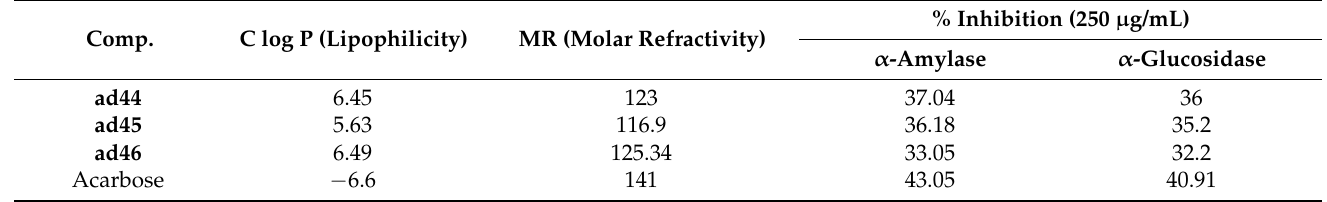
Table 49. Antidiabetic potential of the compounds ( ad44–ad46 ) based on α -amylase and α - glucosidase inhibitory